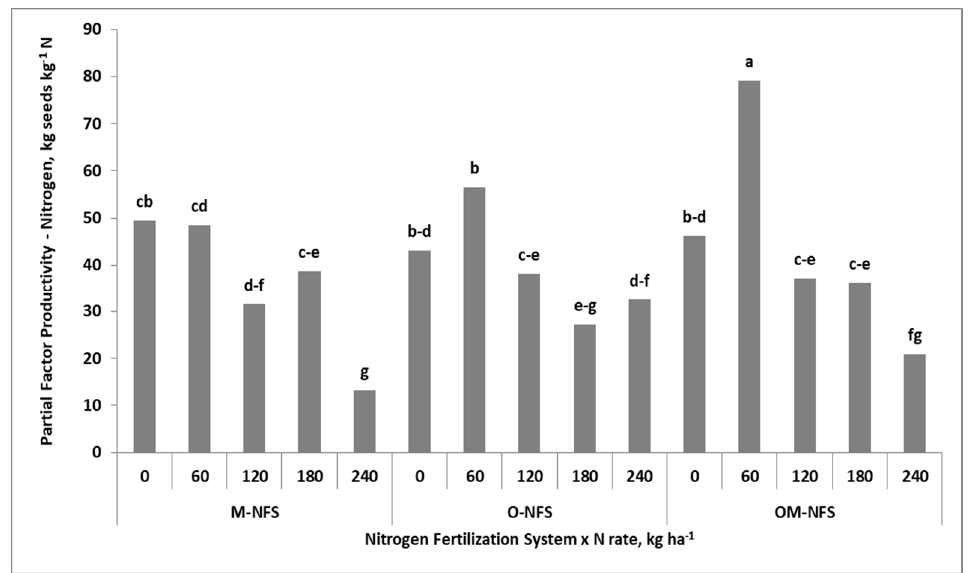
Figure 6. Partial factor productivity of nitrate N at BBCH 30 on the background of nitrogen fertilization systems (NFSs). M-NFS, O-NFS, OM-NFS—mineral, organic, organic-mineral, respectively. a, b, c, d, e, f, g significance letters, a—the highest, g—the lowest; a means within a column followed by the same letter indicate a lack of significant difference between the treatments.